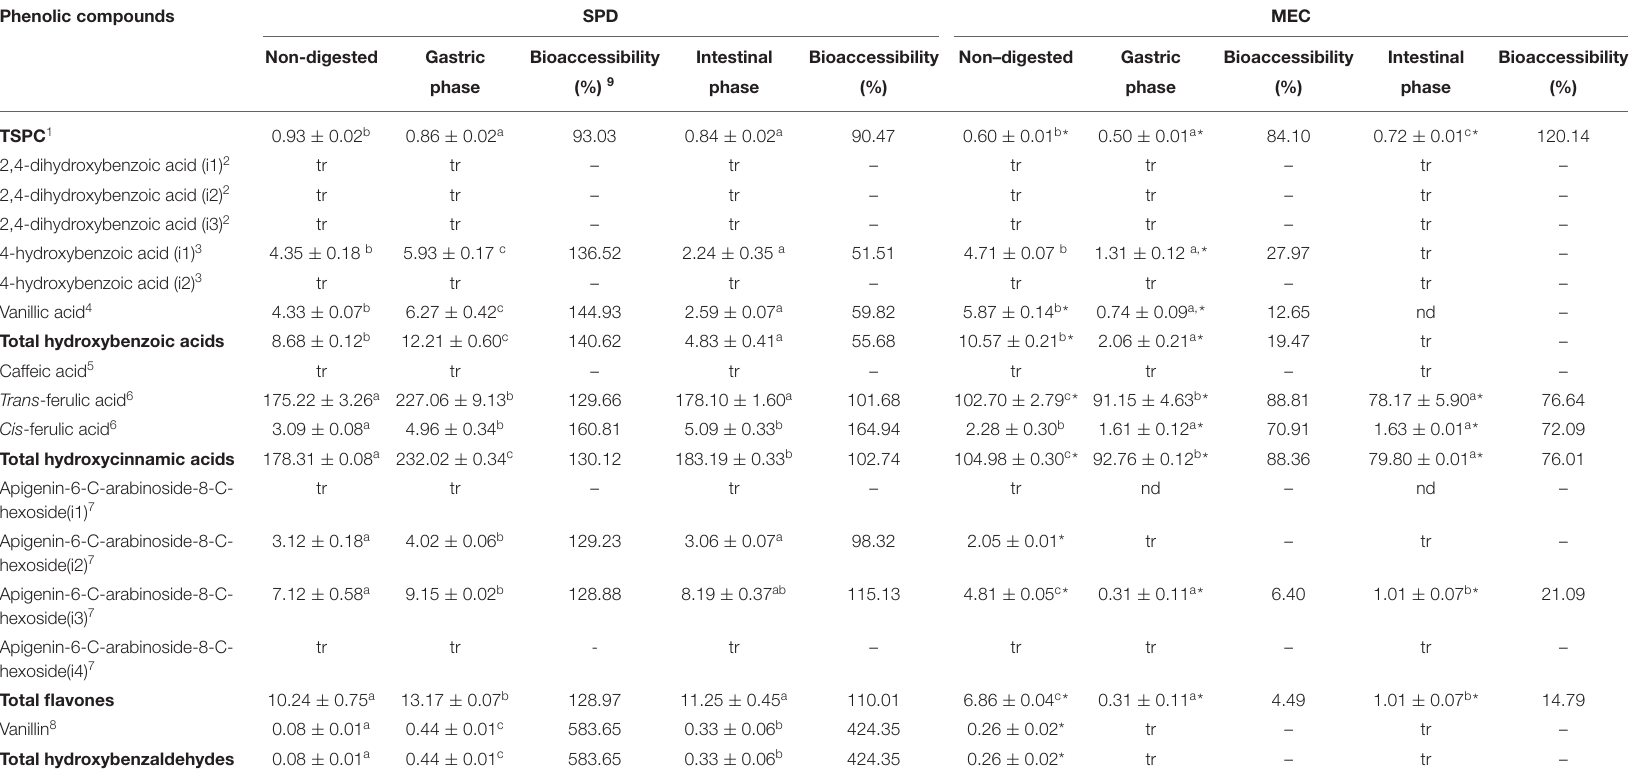
Dataaremean values ± standard deviation ofthreereplicates. Different lowercase letters inthesame row indicate significant differences between means indifferent digestion phases (one-way ANOVA, post-hoc Duncan’s test, p ≤ 0.05). * denotes significant differences among wheat derived ingredients in the same phases of digestion (one-way ANOVA, post-hoc Duncan’s test, p ≤ 0.05). SPD, hydrolyzed WB spray-dried at 130 ◦ C; MEC, hydrolyzed WB spray-dried at 130 ◦ C and microencapsulated with Pisane C 9 ; i, isomer; nd, non-detected; TSPC, total soluble phenolic compounds; tr, traces. 1 g/100g gallic acid equivalents. 2 mg/100g 2,4-dihydroxybenzoic acid (linearity range 0–3.75 µ g/mL, R 2 = 1). 3 mg/100g 4-hydroxybenzoic acid (linearity range 0–3.75 µ g/mL, R 2 > 0.99). 4 mg/100g vanillic acid (linearity range 0.47–3.75 µ g/mL, R 2 > 0.98). 5 mg/100g caffeic acid (linearity range 0–2.77 µ g mL, R 2 > 0.99, LOD =